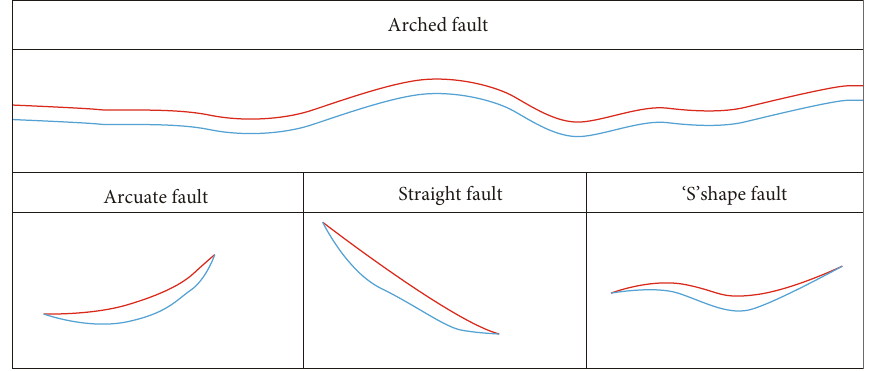
Figure 8: Four types of plane faults in Zhuangnan fault zone.